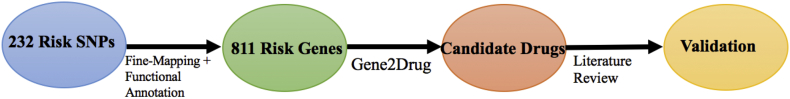
Flow chart of our methodology. Risk SNPs identified in previous IBD GWAS were fine mapped to 811 risk genes. Gene2Drug analysis was performed on the 811 risk genes, which yielded candidate drugs. To validate the candidates, the literature was then consulted to determine the most promising candidates.